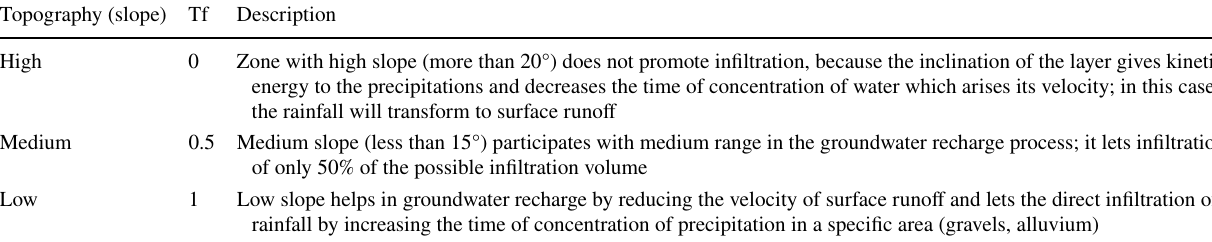
Table 3 Topographical factor (Tf) values Topography (slope) Tf Description